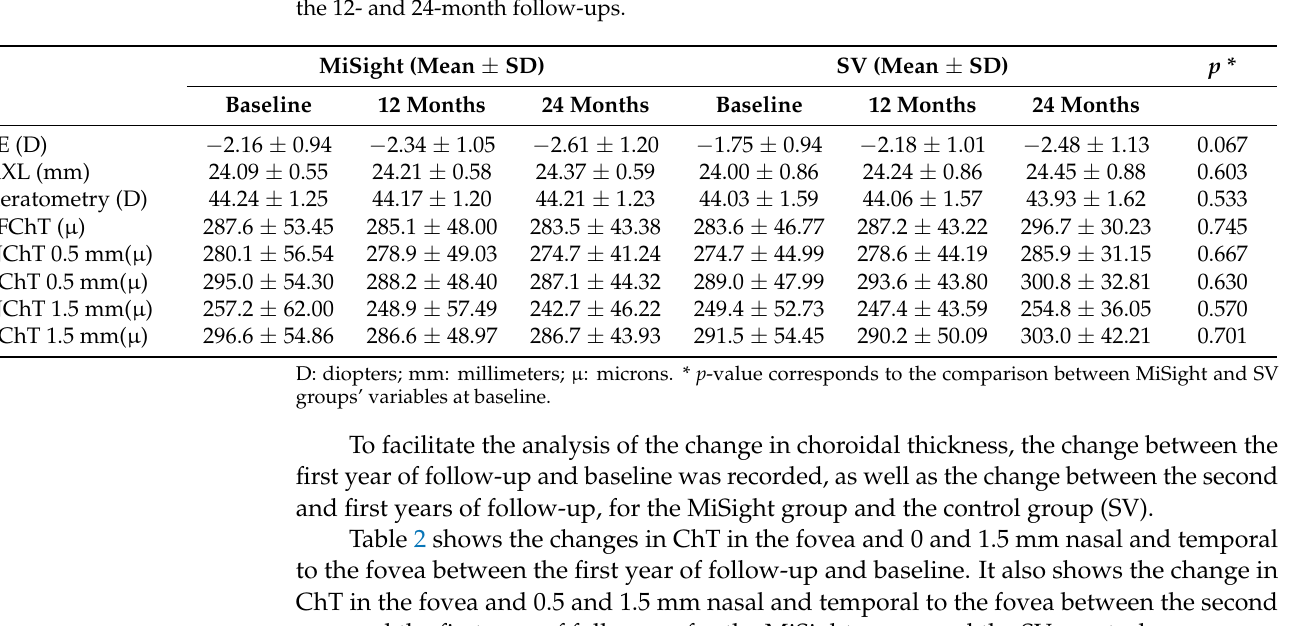
Table 1. Changes in cycloplegic autorefraction (SE), axial length (AXL), mean keratometry, subfoveal choroidal thickness (SFChT), nasal choroidal thickness at 1 mm diameter (NChT 0.5 mm), temporal choroidal thickness at 1 mm diameter (TChT 0.5 mm), nasal choroidal thickness at 3 mm diameter (NChT 1.5 mm), and temporal choroidal thickness at 3 mm diameter (TChT 1.5 mm), at baseline and the 12- and 24-month follow-ups.